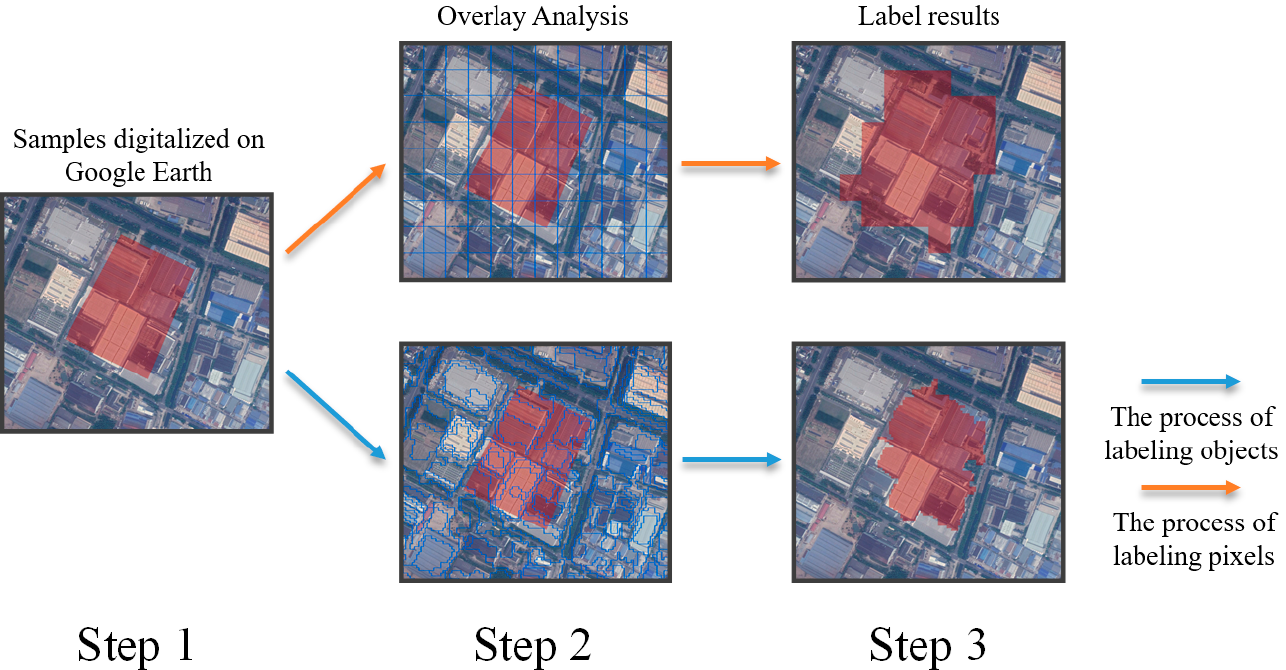
Figure 5. The process of sampling and labeling. In step 1, different LCZ types were digitalized on Google Earth and the red block is an example of the original sample. In step 2, pixels overlaid by the original sample were labeled in a pixel-based process while image objects were labeled according to the overlay ratio we set. Step 3 displays the final samples for a pixel-based method and object method. The blue line and orange line represent the process of labeling objects and pixels respectively.